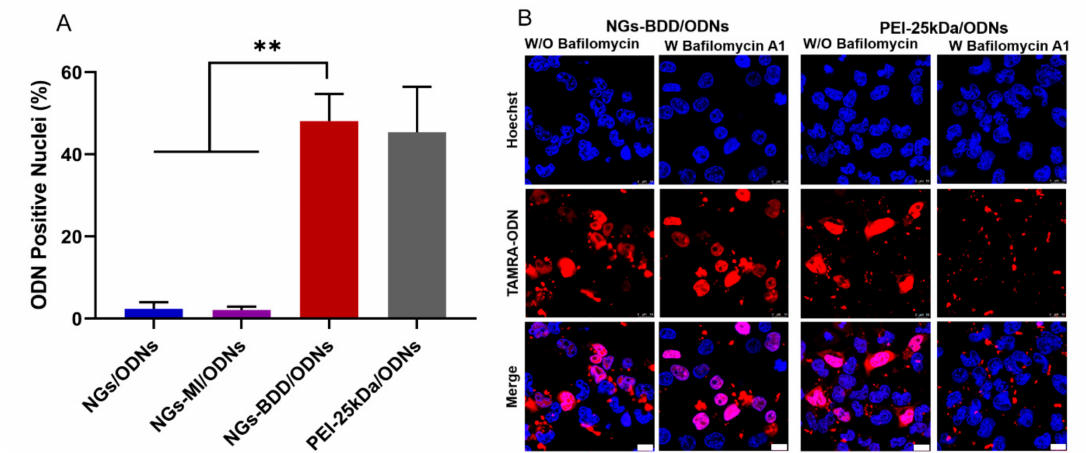
Figure 5. Endosomal escape of TAMRA-labeled ODNs (red) mediated by nanogels and PEI-25kDa in HEK293T cells. ( A ) Semi-quantitative analysis (% cells with ODN positive nuclei) of CLSM images. Data present mean ± SD of three independent experiments and 150–200 cells (9 images in total) per condition (** p < 0.005). ( B ) CLSM images of cells after incubation with NGs-BDD/ODNs and PEI-25kDa/ODNs for 4 h with or without Bafilomycin A1. The cell nuclei were stained with Hoechst33324 (blue). Scale bars are 10 µ